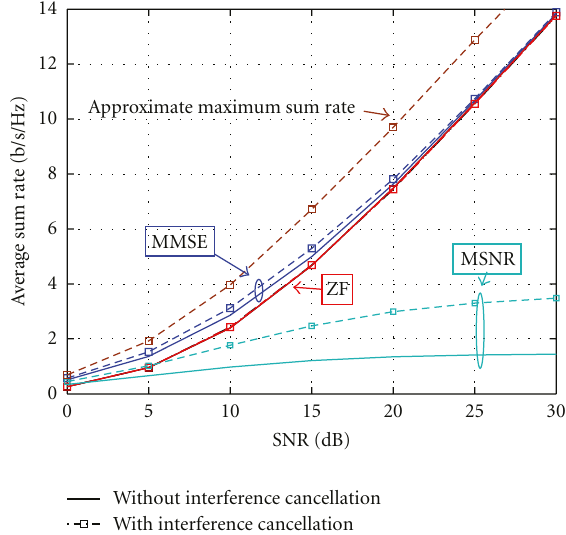
Figure 4: Sum rate performance of three-way relaying for multi- plexing transmission with SMTB and asymmetric tra ffi